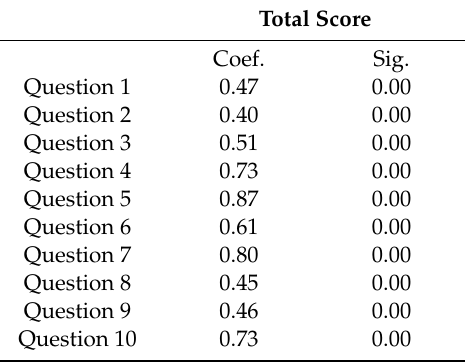
Table 3. Question–total